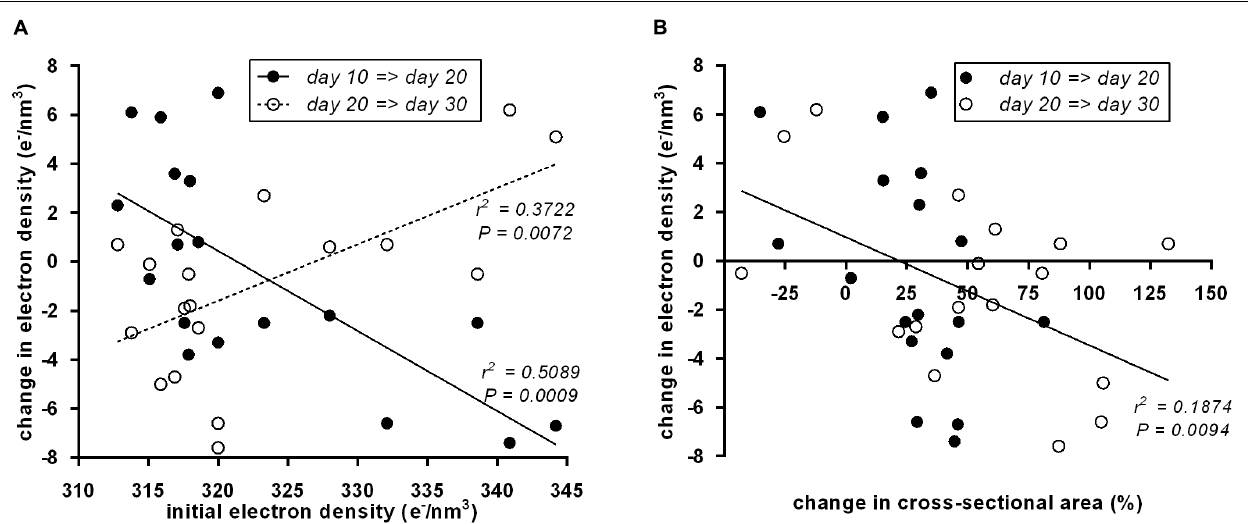
FIGURE 4 | (A) Initial electron density at postnatal day 10 of 18 murine adipose tissue depots was a predictor of subsequent electron density changes. From day 10 to day 20 (black dots), the correlation was negative, i.e., white fat becomes brown and brown fat becomes white. From day 20 to day 30 (white dots), the reversal of transient “browning” and “whitening” manifested in a positive correlation. Dots represent mean values ( n = 3). (B) Within both periods, day 10 to day 20 (black dots) and day 20 to day 30 (white dots), a change in depots size negatively correlated to changes in electron density, i.e., depots shrank/grew less during “browning” and grew more during “whitening.” Dots represent mean values ( n =